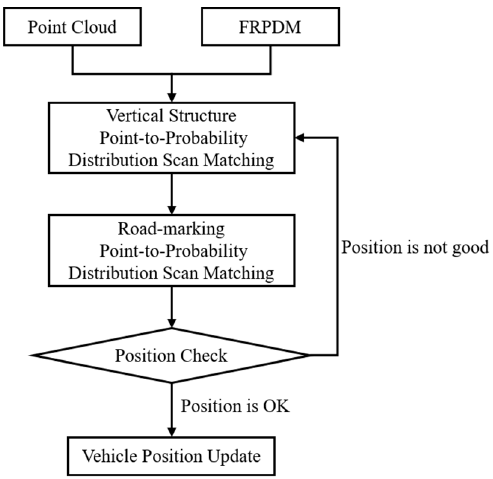
Figure 27. Example of map matching result when initial position error is large. ( a ) Single resolution PDM (2 m), ( b ) FRPDM.